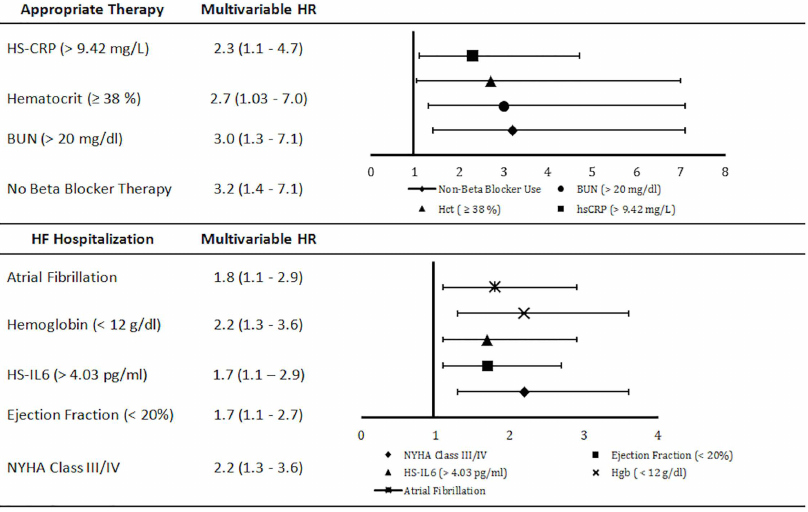
Fig 1. Multivariable hazard ratios for appropriate therapy and HF